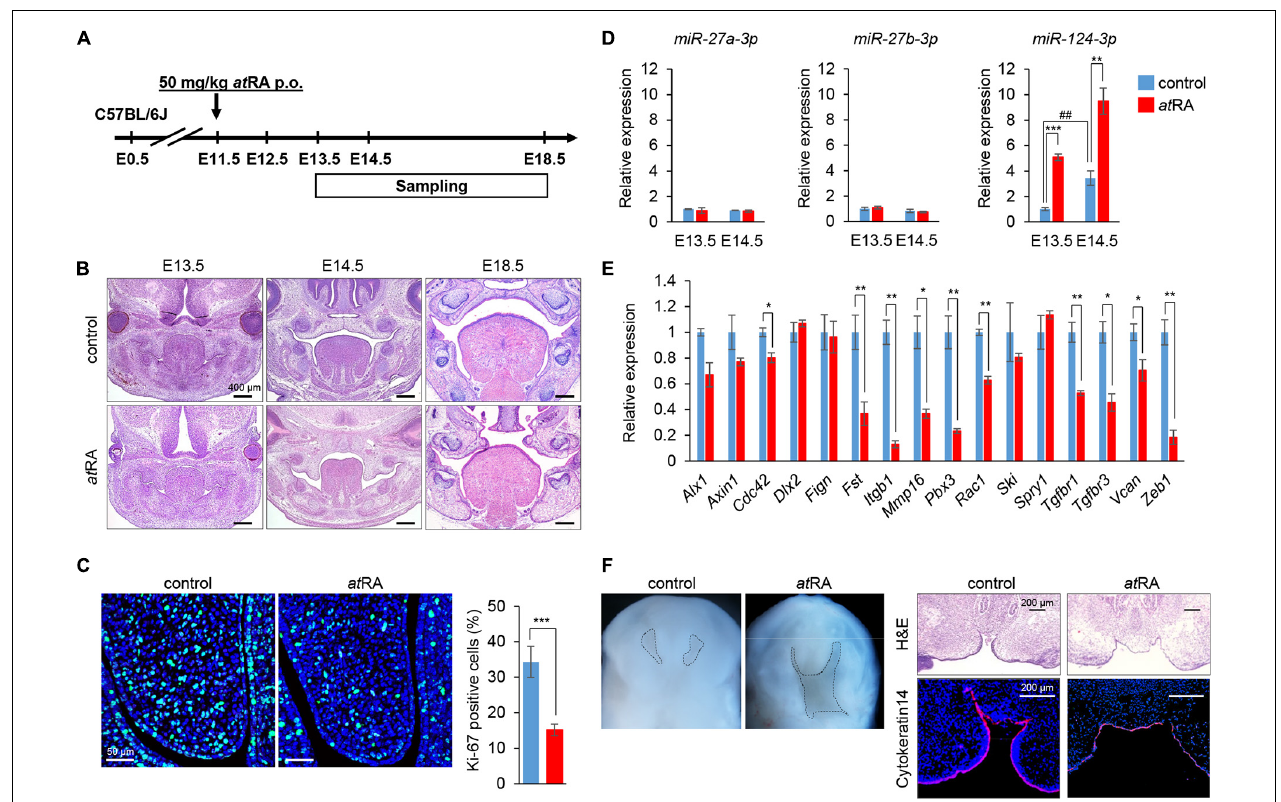
FIGURE 5 | Influence of at RA administration on palatal development and gene expression in mice. (A) Schematic experimental design. (B) H&E staining of face at E13.5, E14.5, and E18.5. Bars, 400 µ m. (C) Ki-67 staining (green) in the developing palate of E13.5 mice treated with control vehicle or at RA (50 mg/kg p.o. at E11.5). Nuclei were counterstained with DAPI (blue). Representative images from two independent experiments are shown. Graph shows the quantification of Ki-67-positive cells. Independent t -tests. *** p < 0.001 vs. control. Bars, 50 µ m. (D) Quantitative RT-PCR for miR-27a-3p, miR-27b-3p, or miR-124-3p after administration of at RA in palatal shelves at E13.5 and E14.5. Two-way ANOVA with Tukey’s honest significant difference test ( n = 3). ** p < 0.01, *** p < 0.001 vs. control at each indicated day and ## p < 0.01 vs. E13.5 control. (E) Quantitative RT-PCR for the indicated genes after treatment with at RA for 24 h in palatal shelves at E14.5. Multiple t -tests adjusted by Bonferroni ( n = 3–6). *Adjusted p < 0.00313 (16 genes), **adjusted p < 0.000625 (16 genes) vs. control. (F) Intraoral views of heads (left panels) from E13.5 embryos, from which the mandible and tongue were removed and cultured for 3 days with control vehicle or at RA ( n = 4 per group). Dashed lines delineate the palatal shelves. H&E staining and K14 immunostaining (red) (right panels) of coronal sections of 3-day cultured explants with control vehicle or at RA. The nuclei were counterstained with DAPI (blue). Bars, 200 µ